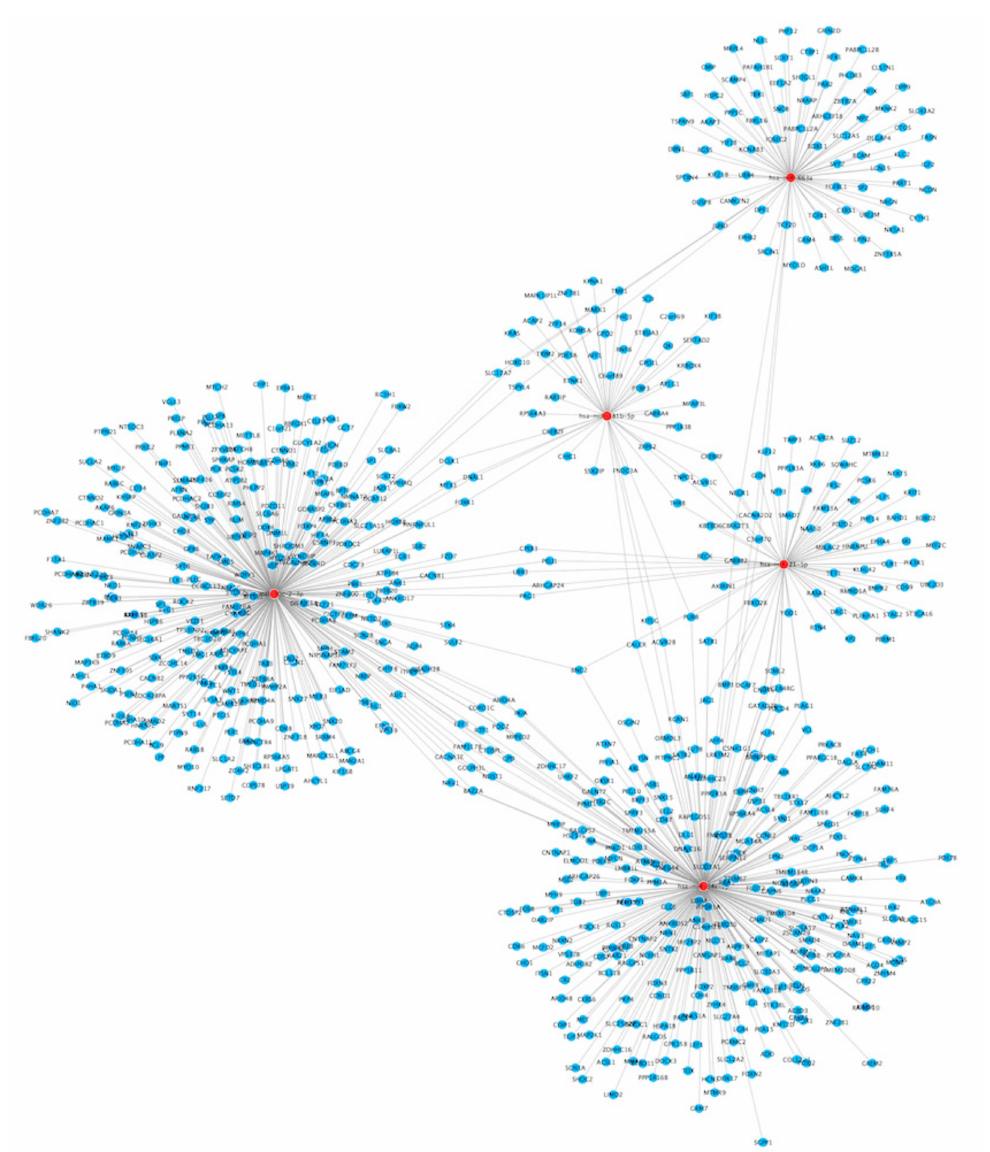
Figure 6. miRNAs modulated by polyphenols (red circles), their target mRNAs (blue circles), and